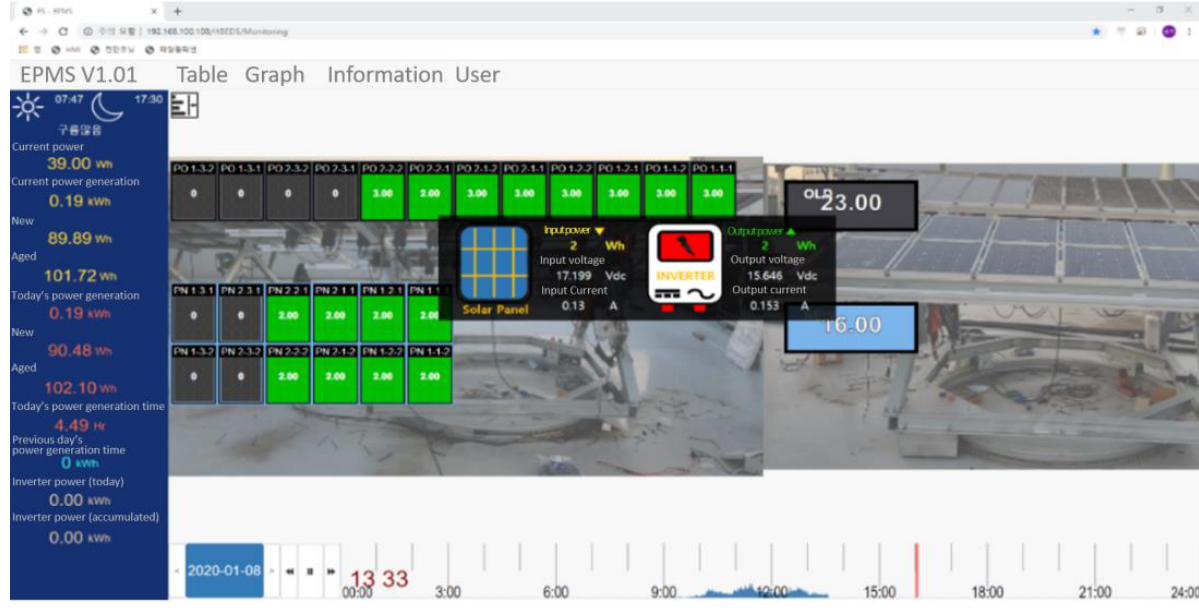
Figure 2. Configuration of the PV monitoring section.